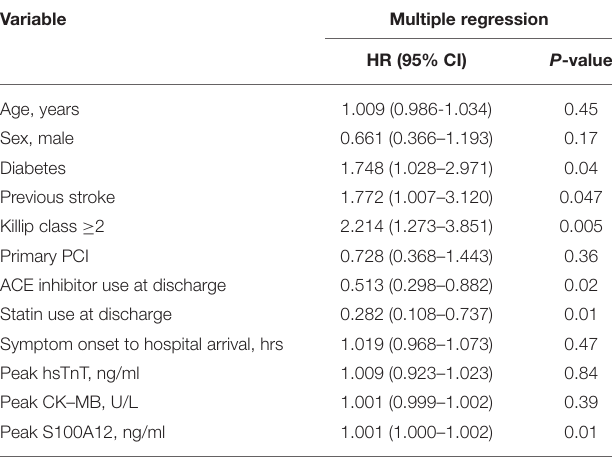
TABLE 4 | Independent predictors of 1-year MACCE in cohort 3 patients with STEMI.